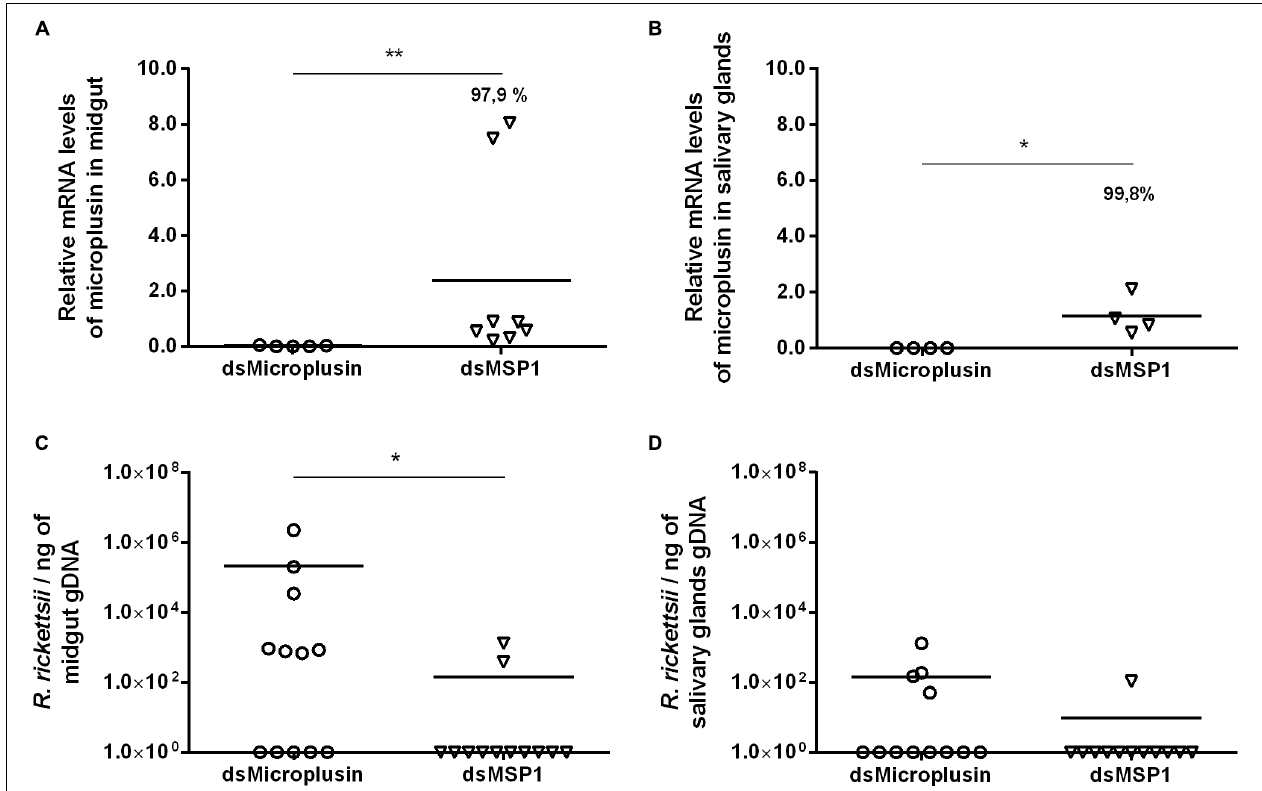
FIGURE 4 | Effect of RNAi-mediated silencing of microplusin in R. rickettsii acquisition by A. aureolatum . Specific dsRNA for either microplusin (dsMicroplusin) or MSP1 (dsMSP1; control) were injected into the hemocoel of non-infected ticks. After 24 h, ticks were fed on R. rickettsii -infected rabbits for 3 days. The relative expression of microplusin in midgut (A) and salivary glands (B) of ticks injected with dsMicroplusin in relation to the control was assessed by RT-qPCR and the rickettsial load in MG (C) and SG (D) by qPCR ( ∗ p < 0.05 and ∗∗ p < 0.005; Mann–Whitney